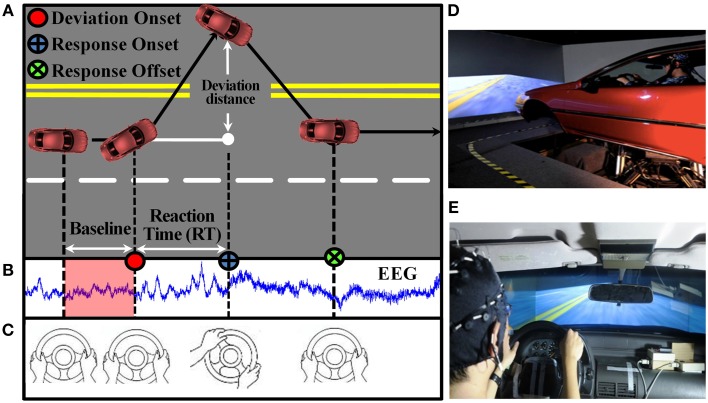
Sustained-attention driving task. (A) Event-related lane-deviation paradigm. (B–C) EEG and behavior were recorded simultaneously. (D) The experimental paradigm was implemented in a VR-based driving simulator, where a 3-D surrounding view simulated a monotonous highway scene and a vehicle was mounted on a six degree-of-freedom dynamic platform. (E) The car speed was fixed at 100 km/h and the subject was asked to keep the car cruising on the central of the lane.